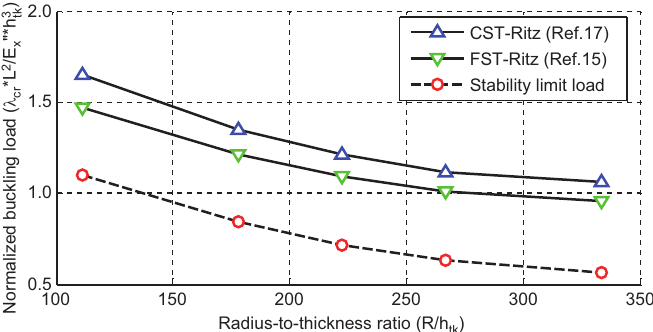
Figure 6 Variation of linear buckling and stability limit loads with the change of radius-to-thickness of the clamped-clamped hybrid laminate with lay-up confi guration LC 1